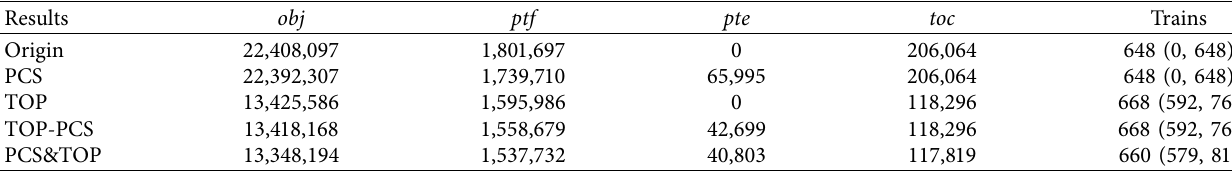
Table 6: Result comparison of different